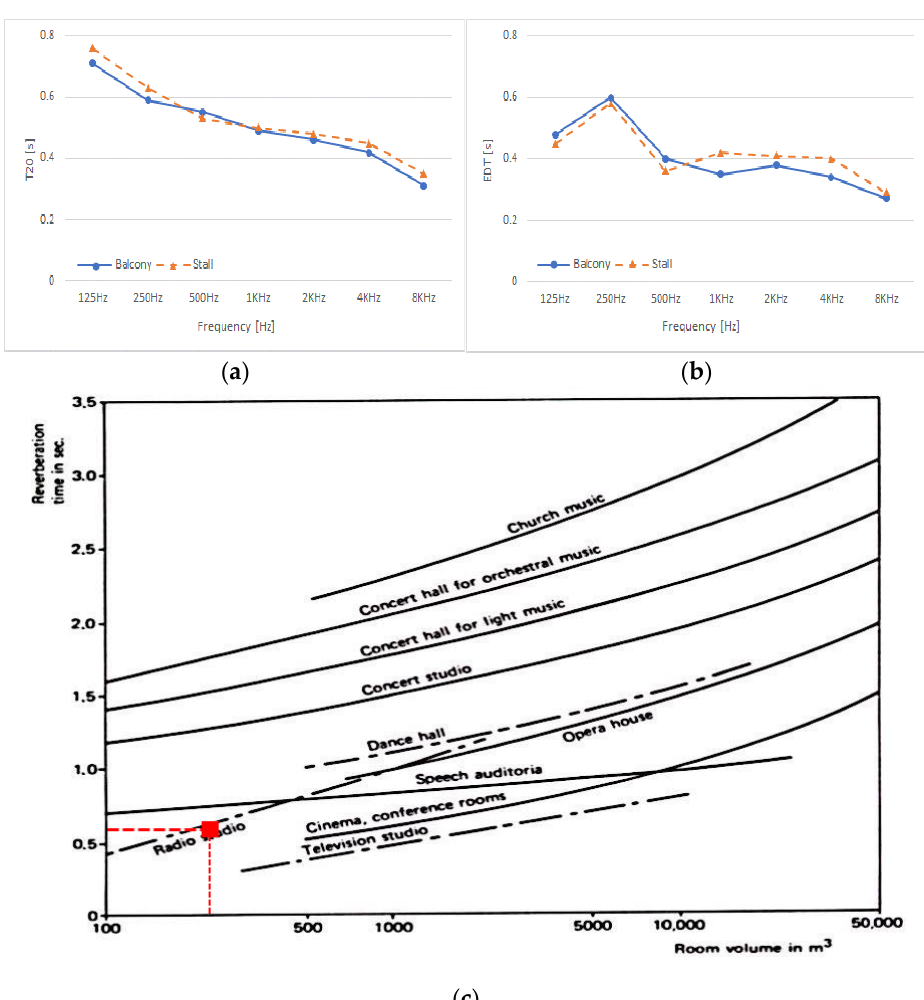
Figure 9. Measurement results of the acoustic parameters: Reverberation Time ( a ), Early Decay Time ( b ), and Optimal T 20 values at 500 Hz, based on room volume ( c ).